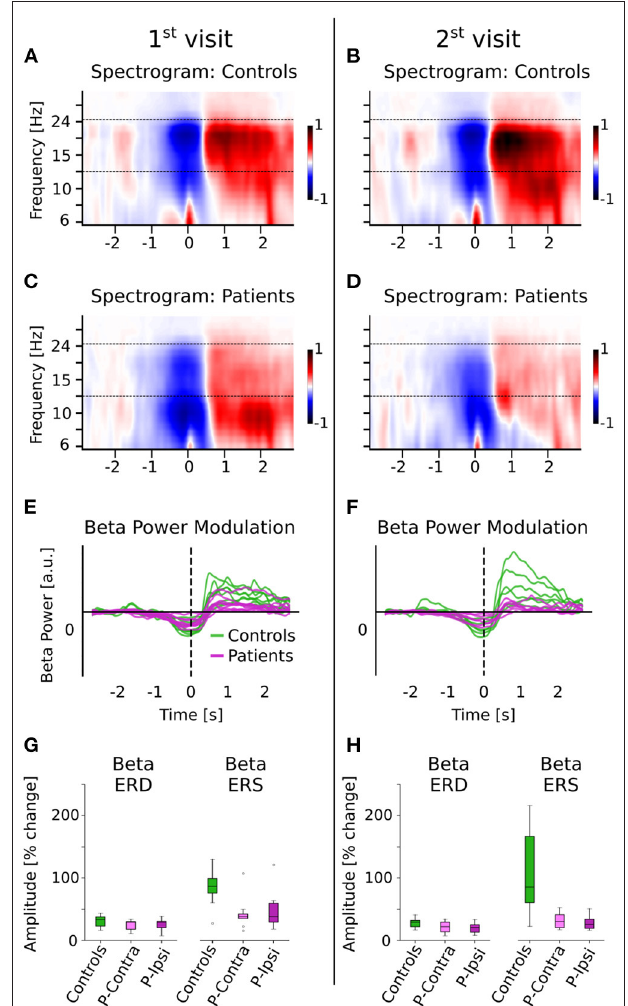
FIGURE 1 | Beta power in controls and patients. (A) Source localized beta band power for controls and patients averaged across all tasks. The black outline indicates the ROI used for all further analysis. Although patients and controls have similar beta activity in occipital areas, controls have much stronger activity in the rolandic ROI. (B) Power spectral density of patients and controls averaged across all tasks in the central ROI for the 1st visit. There is a clear group difference in the beta range (13–25Hz). (C) Relative beta power for controls and patients for the 1st visit, separated by ipsi-lesional and contra-lesional hemispheres. Clear differences between controls and patients are seen, but there are no notable differences within patients between ipsi-lesional and contra-lesional hemispheres. (D) Power spectral density for the 2nd visit. Note that only a subset of subjects returned for the 2nd visit. The 1st visit spectrum averaged across only this subset of subjects is shown as an inset for comparison. (E) Relative beta power for controls and patients for the 2nd visit, separated by ipsi-lesional and contra-lesional hemispheres. Patients show reduced power even after ∼ 6 months postinfarct. There are no notable differences within patients for ipsi- and contra-lesional hemispheres.